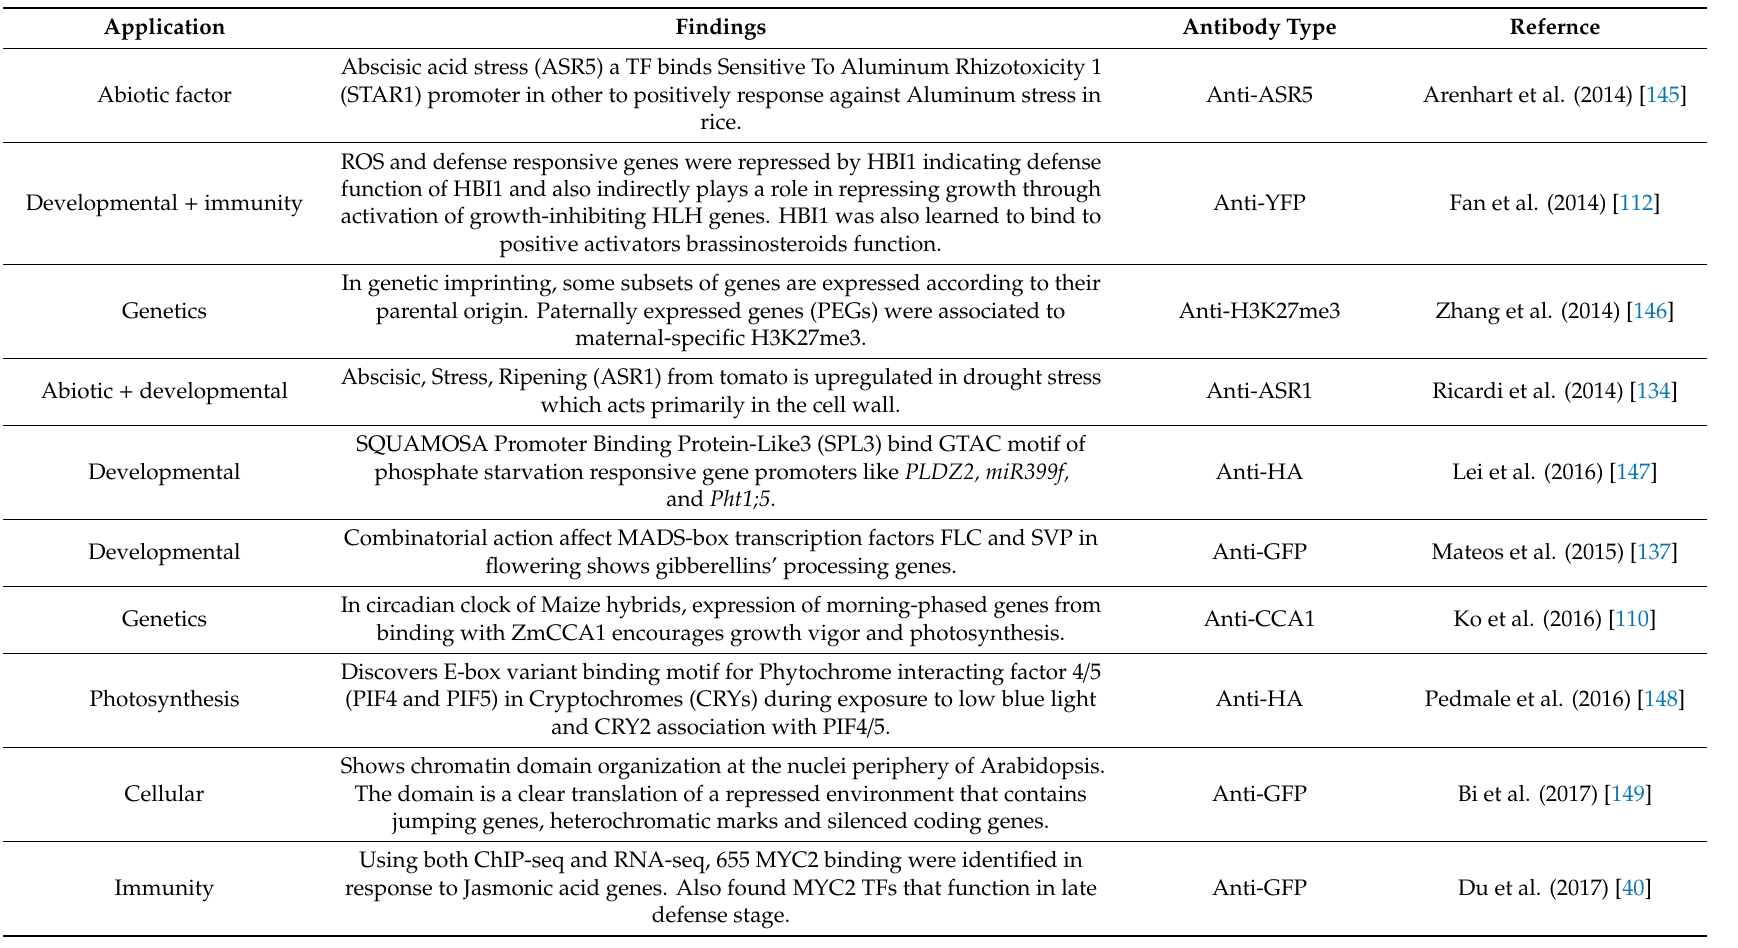
Table 1. A summarized ChIP-seq research findings highlighting the kind of research and type of antibody